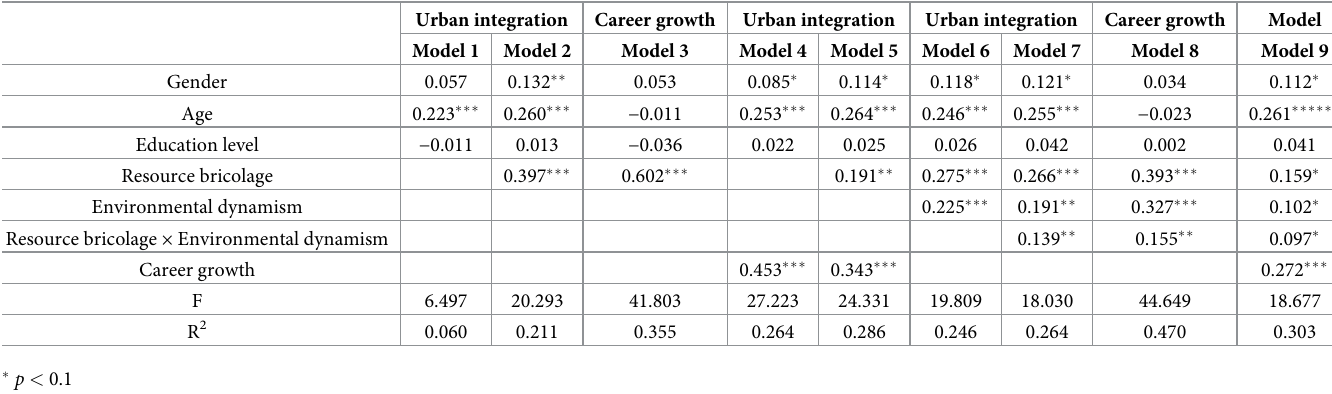
Table 4. Regression analysis